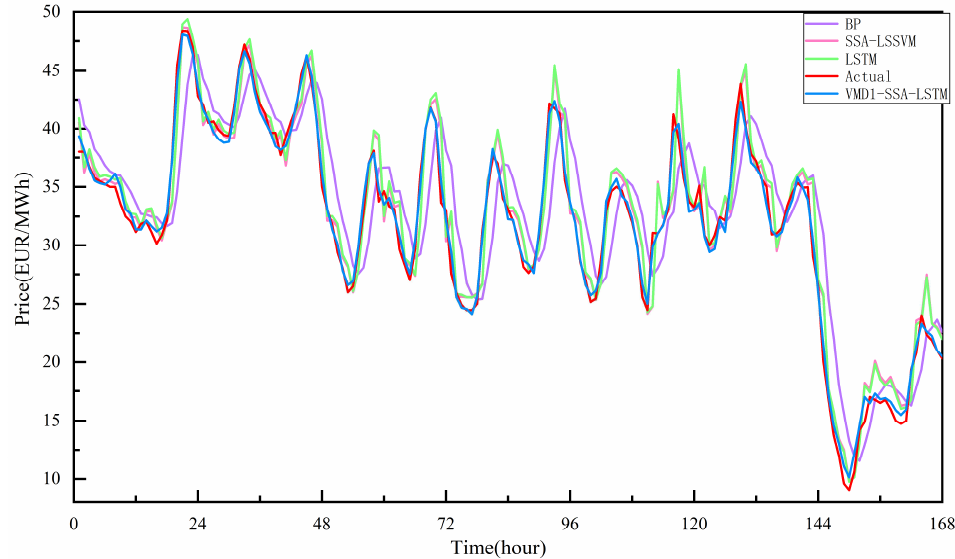
Figure 9. Curve of winter forecast results for Spain.